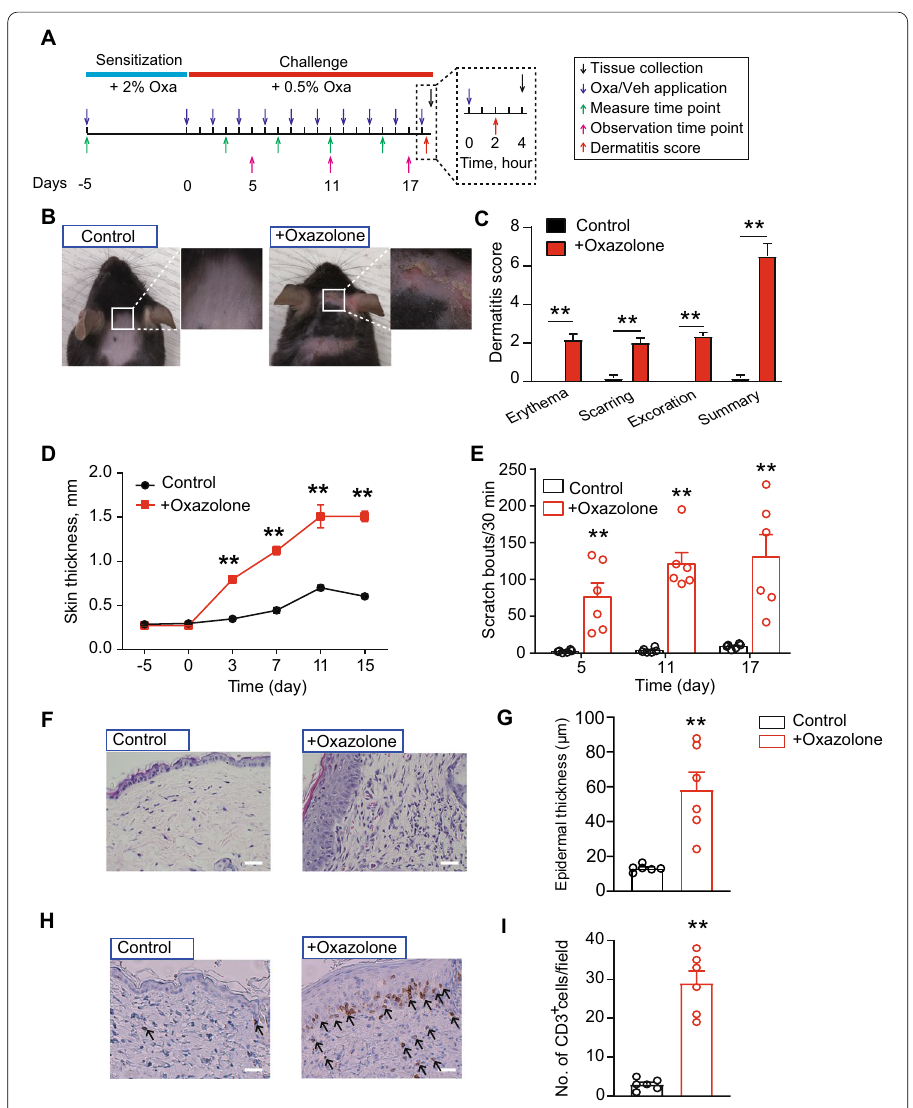
Fig. 1 The establishment of the mouse model of ACD by oxazolone sensitization and challenge and evaluations. A Protocol for the establishment of the oxazolone (Oxa)-induced ACD model in mice. Control group receive vehicle (acetone) treatment only. B Typical pictures showing the neck skin condition of mice in vehicle- or oxazolone-treated group. C Pathological dermatitis scores of control and oxazolone group mice. D Bi-fold skin thickness evaluation of the neck skin of control and oxazolone group of mice. E Scratching behavior of mice treated with oxazolone or vehicle. F Representative pictures of hematoxylin and eosin (H&E) staining of neck skin of control and oxazolone group of mice. G Summary of epidermal thickness of control and oxazolone group mice. H Representative pictures of immunohistochemistry staining of CD3 + cells in neck skin of control and oxazolone group mice. I Summary of the number of CD3 + cells per observation field. n 6 mice per group. ** p < 0.01 versus control group. Scale bar, 100 =